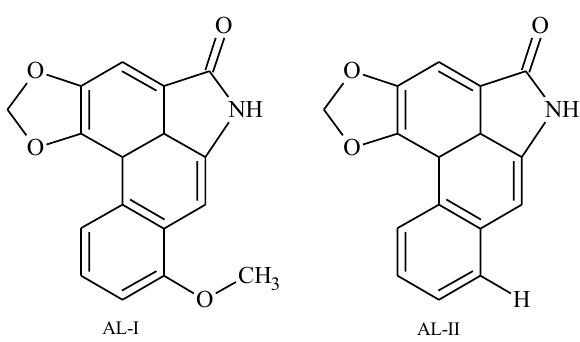
Figure 1. Aristolactam